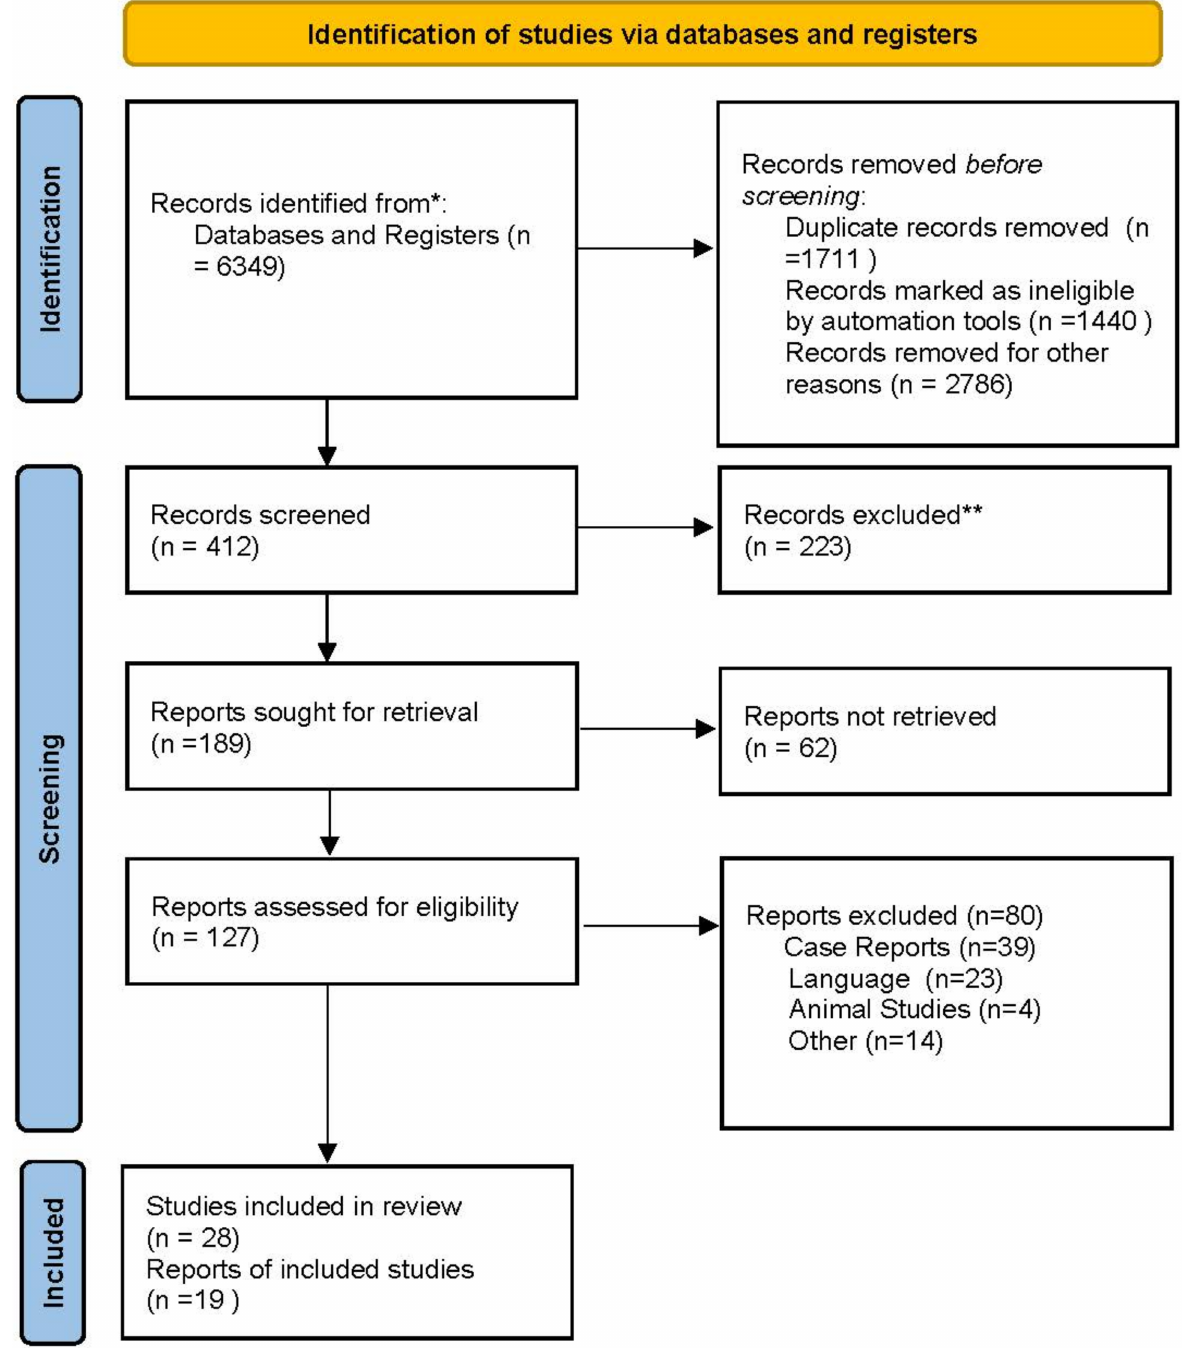
Figure 2. Prisma FloW Chart 2020 allowed to reach 47 determinant publications for the systematic review. * Search database; ** excluded for no meet